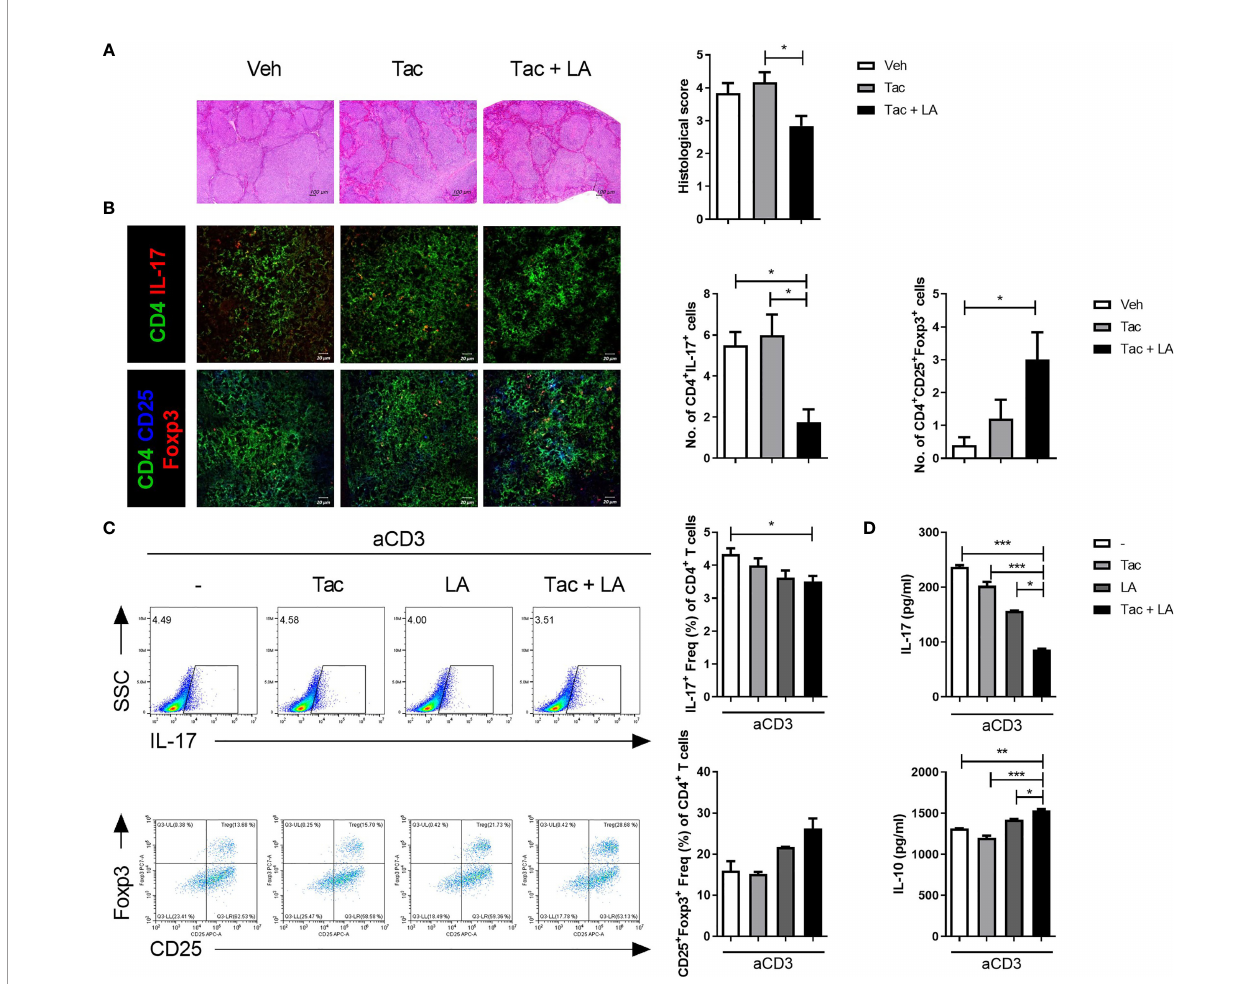
FIGURE 4 | The imbalance between Th17 and Treg cells in lupus-prone mice was alleviated by the combination treatment of Tac and LA. After the in vivo experiments, as described in Figure 2 , cryosectioned spleen tissues were acquired at the time of sacri fi ce. (A) Representative photomicrographs of spleen tissues stained with H&E (left panels, original magni fi cation ×40) and their histological scores (right panels). (B) Confocal photomicrographs of CD4+IL-17+ cells (Th17), and CD4+CD25+Foxp3+ cells (Treg) in spleen tissues (left panels, original magni fi cation ×200). Cell counts are shown in the right panels. (C) Total splenocytes extracted from the spleens of MRL/ lpr mice were cultured with Tac (0.1 nM) and/or LA (100 m g/ml), under stimulation with anti-CD3 antibodies (0.5 m g/ml) for 96 h. Flow cytometry data of the proportion of IL-17-(upper panels) and Foxp3-expressing (lower panels) cells, expressed as the dot plots (left panels) and bar graphs (right panels). (D) Levels of IL-17 and IL-10 in the supernatants of splenocytes cultured under the same conditions as (C) . All experiments were performed at least three times in triplicate. Data are shown as mean ± SEM. * p < 0.05, ** p < 0.01, *** p <